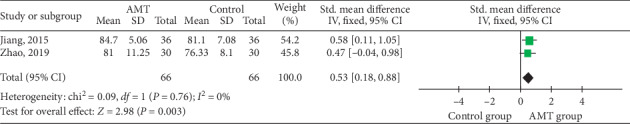
Meta-analysis of the RCTs comparing living quality between AMT group and control group.